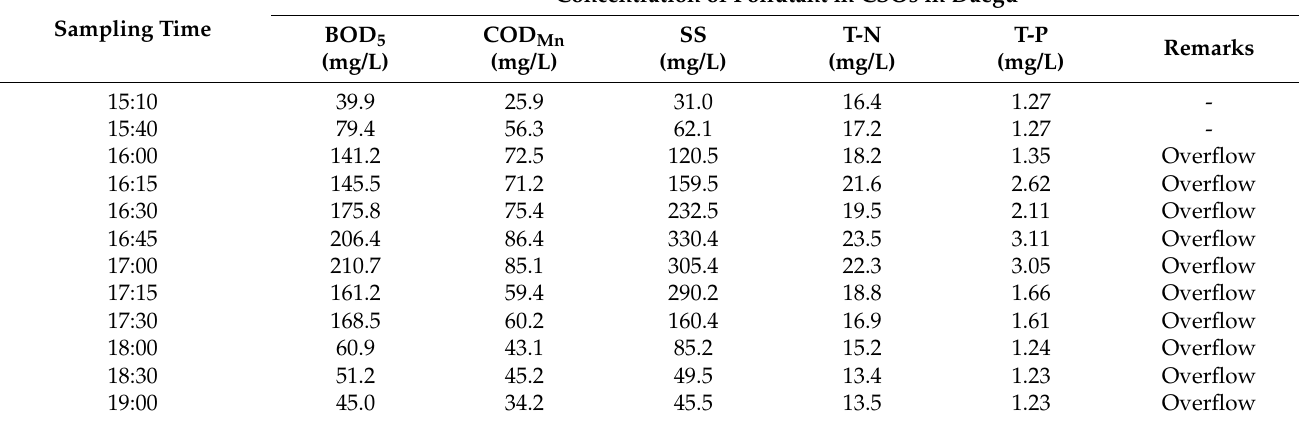
Table 1. Water quality of CSOs in Daegu overflows.